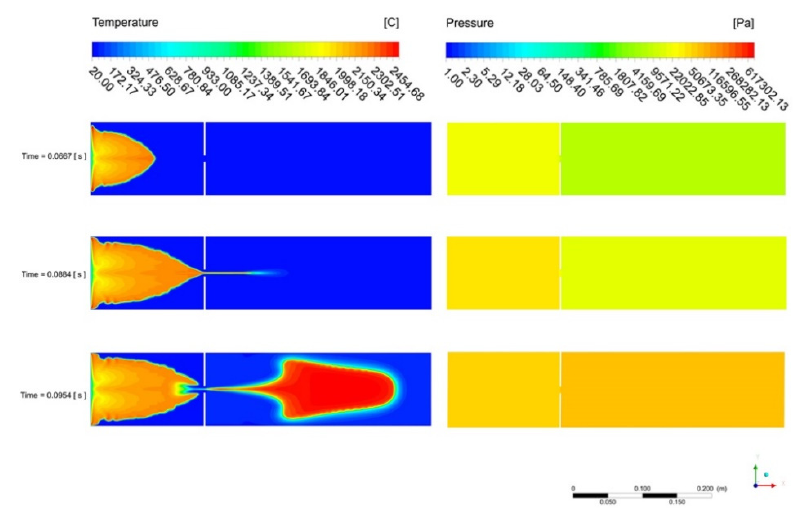
Figure 10. Distribution of temperature field and explosion pressure field.